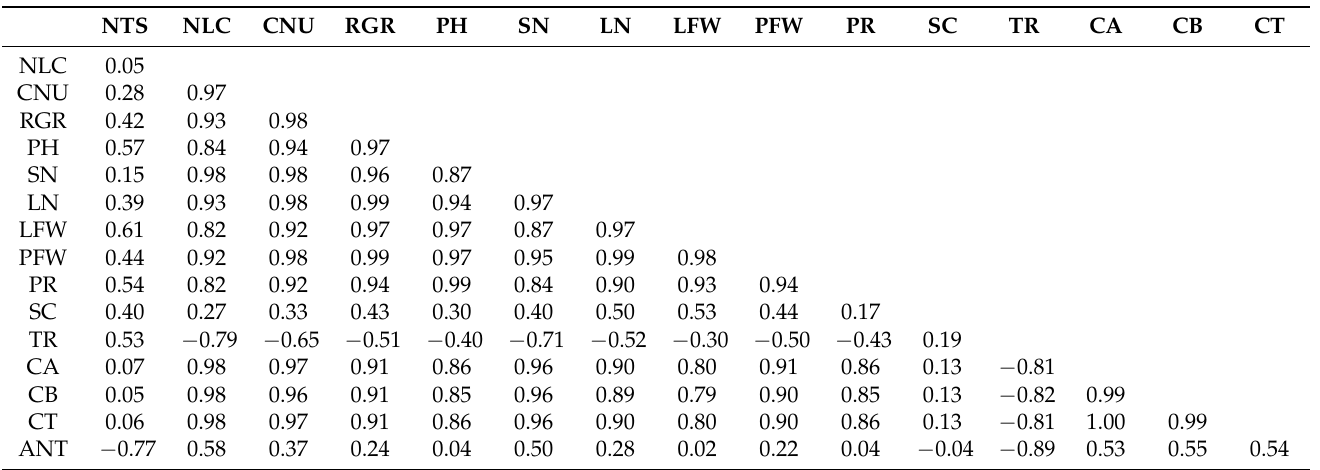
Table 1. Pearson correlation analysis between nitrogen status, characteristics of production and physiology of kaffir